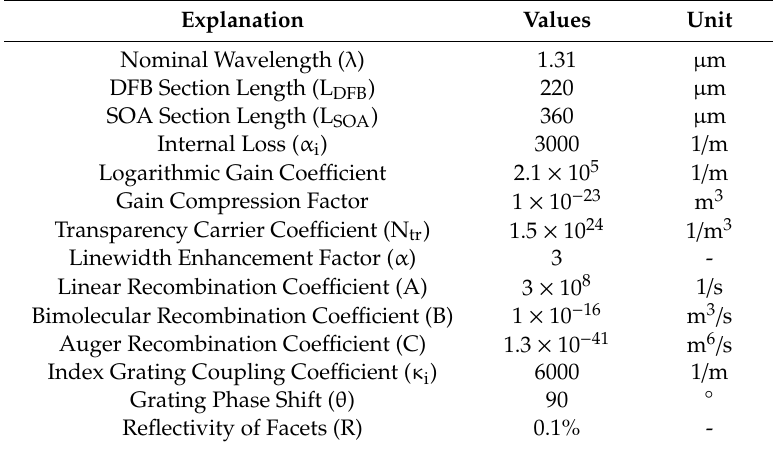
Figure 1. Conceptual diagram of the integrated mutually coupled (IMC) laser in the simulation. Table 2. Parameters used in the simulation.